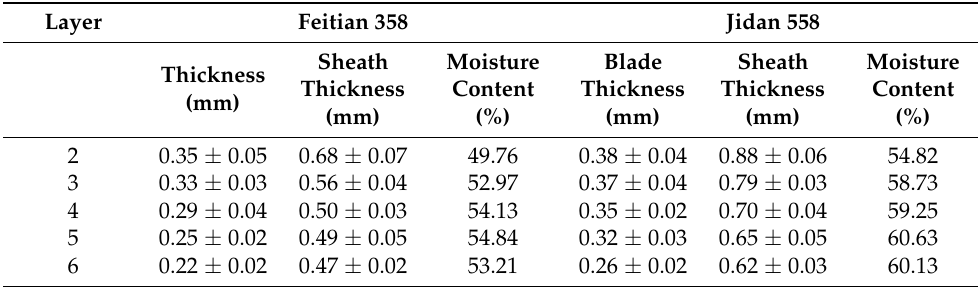
Table 2. Physical properties of the second to sixth bracts used in this study (mean ± SD).